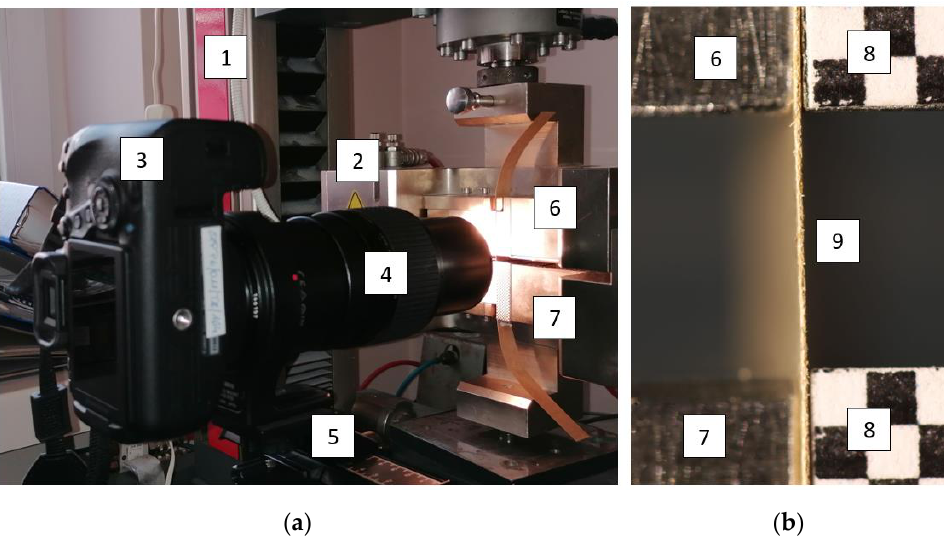
Figure 1. View of ( a ) the measuring station, ( b ) the handles of the testing machine with sticked checkerboard patterns and the paper sample to be tested. The stand consists of a testing machine (1) Zwick Roell Z 010, an SCT test holder (2), a camera placed on a tripod (3)—a Canon EOS 6D Mark II full-frame DSLR with a Canon MP-E 65 mm f/2.8 1–5 × Macro lens (4) and an illuminator providing constant illumination with the possibility of adjusting its direction (not visible in the photo).